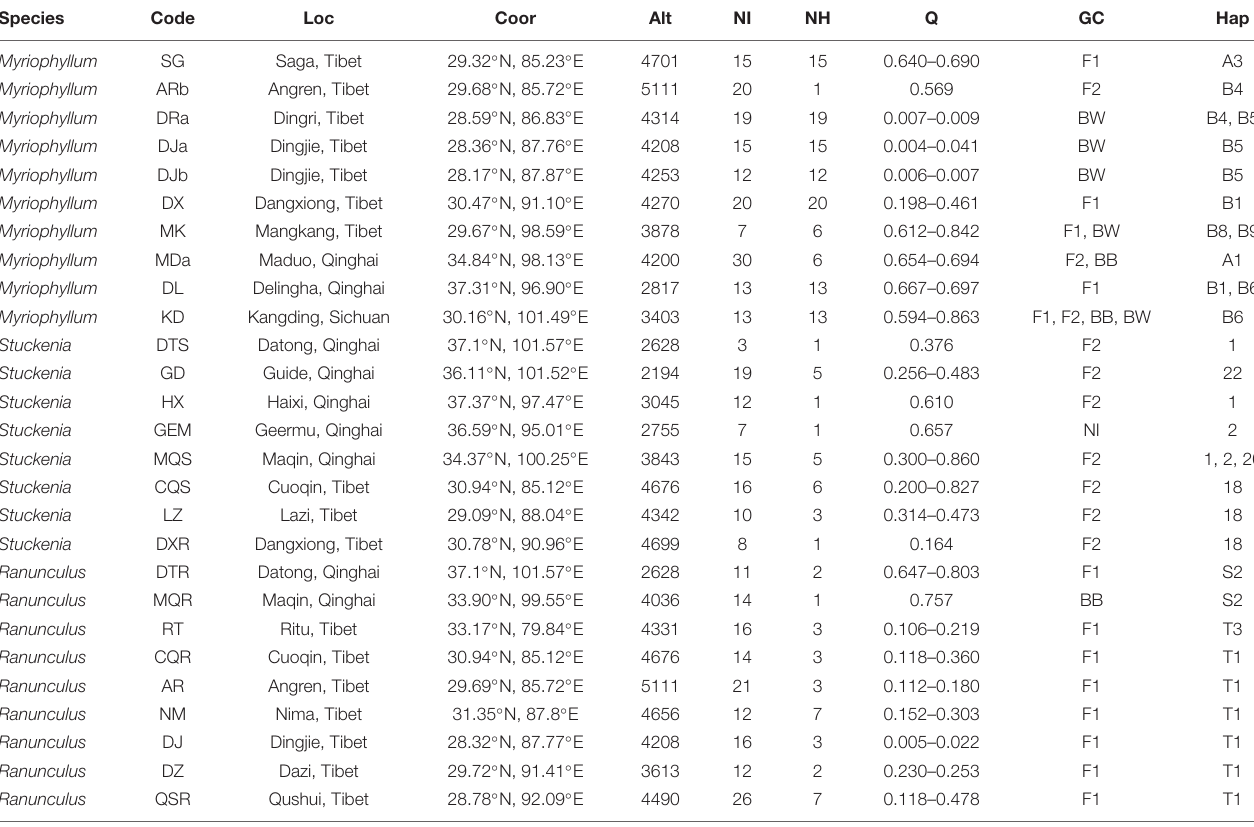
TABLE 1 | Geographic locations, numbers of samples and hybrids, Q values of STRUCTURE and genotype class assignment of NewHybrids revealed by microsatellite markers, and cpDNA haplotypes for the populations involved in hybridization events.